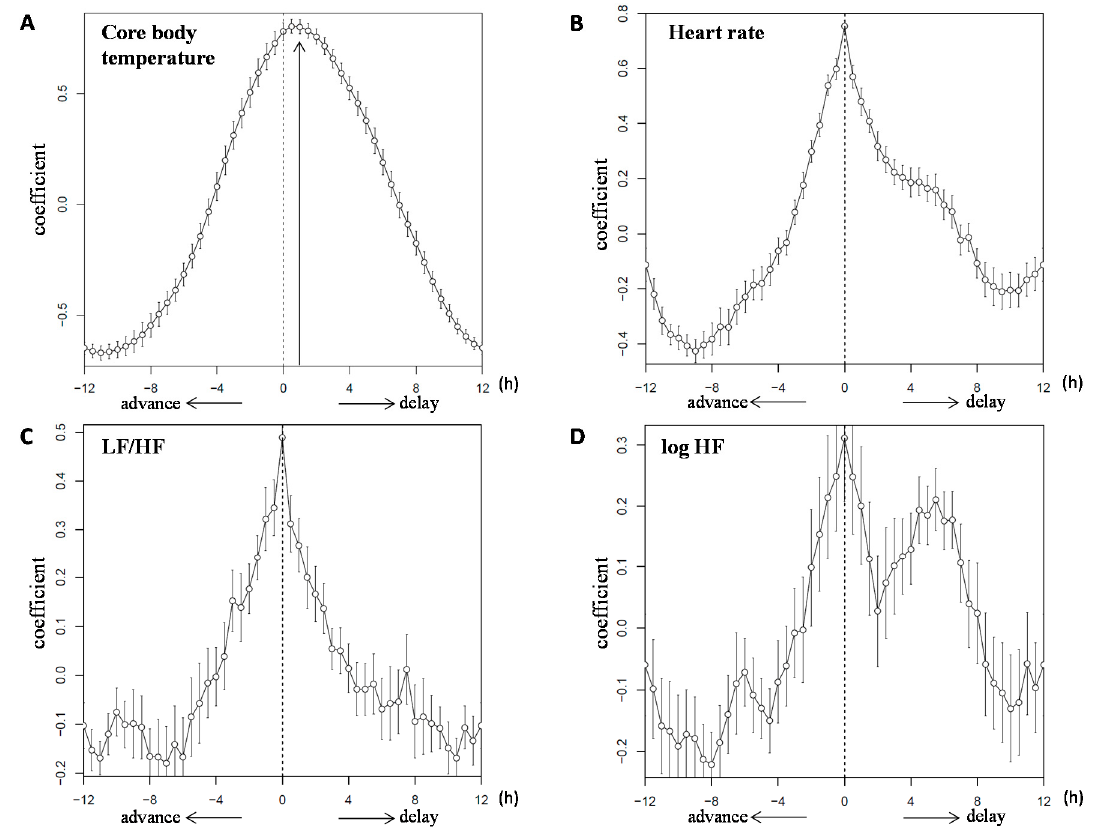
Figure 3. Circular correlation of core body temperature, heart rate, LF / HF, and log HF. The circular correlation of the mean value ± SEM for core body temperature ( A ), heart rate ( B ), LF / HF ( C ), and log HF ( D ) in the 2 dietary conditions. Note that the 2M condition was plotted according to the 3M condition. LF / HF, the power ratio of low frequency to high frequency; HF: high frequency.